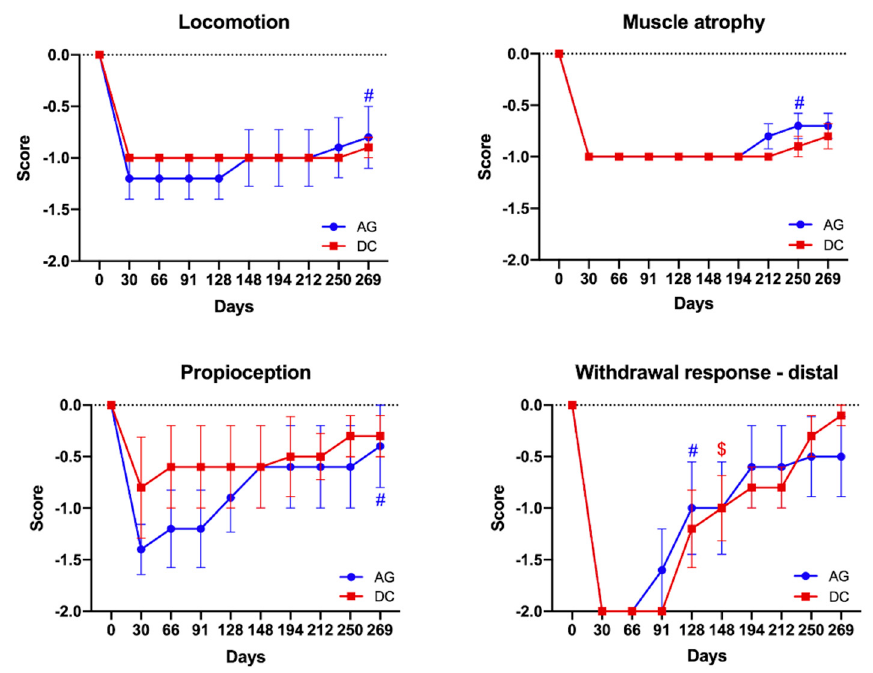
Figure 4. Plots of the functional evaluation along the 9 months follow-up in the two groups of sheep. Similar evolution was observed for all the tests applied, without significant differences between the groups AG and DC. Regarding the time evolution, AG group ( n = 5) showed a significant recovery in all the tests applied (# p < 0.05) vs. baseline at 30 days post-operation, while animals of DC group ( n = 5) only showed a significant recovery in the withdrawal response-distal ($ p < 0.05) vs. baseline at 30 days post-operation.